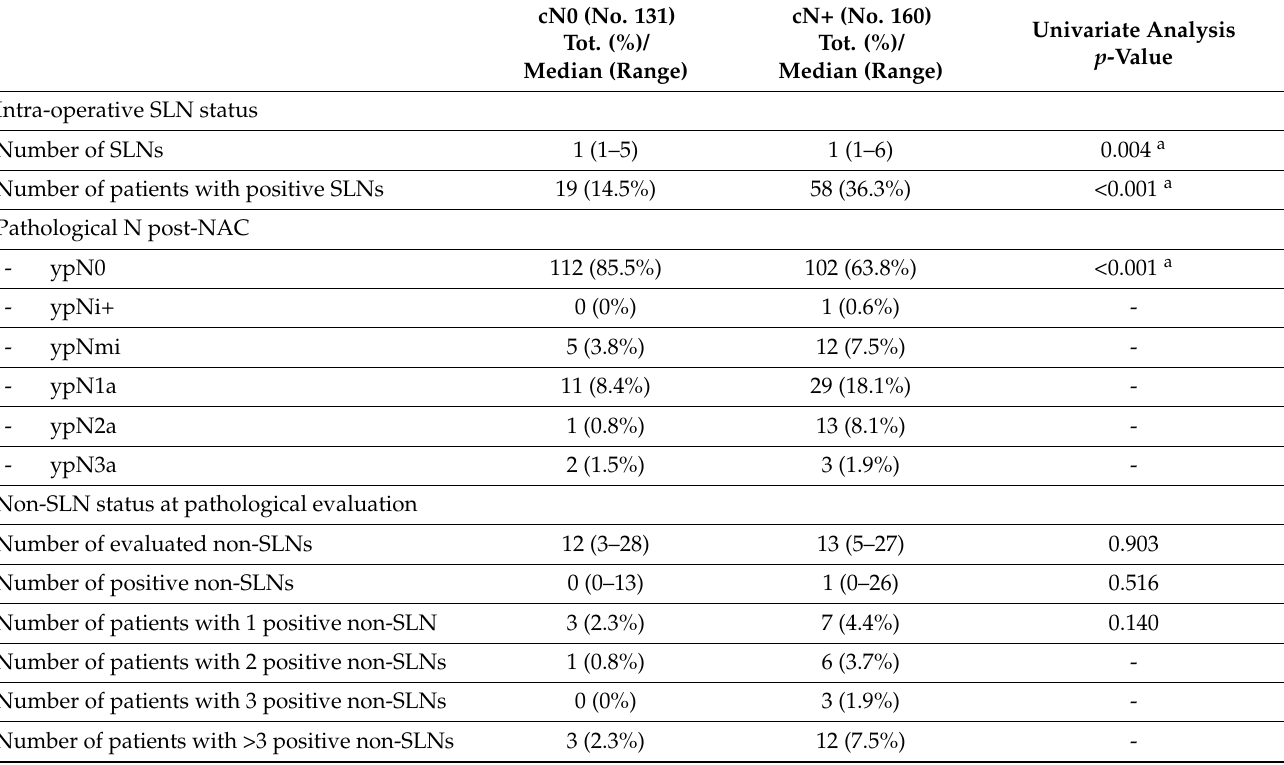
Table 2. Axillary lymph node characteristics of breast cancer patients according to cN status prior to neo-adjuvant chemotherapy. cN+ (No. cN0 (No. 131) Tot. (%)/ Median (Range)